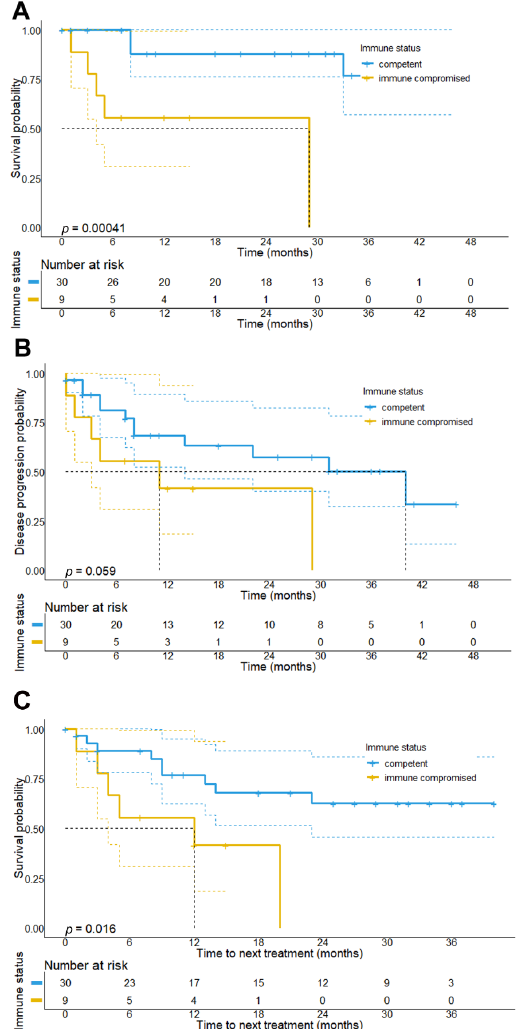
Figure 3. Overall survival, progression-free survival, and time-to-next treatment (TTNT) stratified by the immune status of the patients. Results show that patients being immunocompromised at the start of CPI treatment have a significantly shorter overall survival (29 months vs. NR, p < 0.001) ( A ) and progression-free survival (11 months, 95% CI: 0–28.1 months vs. 40 months, 95% CI: 16.9–63.1 months, p = 0.059) ( B ), as well as TTNT (median TTNT: 12 months, 95% CI: 0–29.1 months vs. NR; p = 0.016) ( C ) as compared to immunocompetent patients.